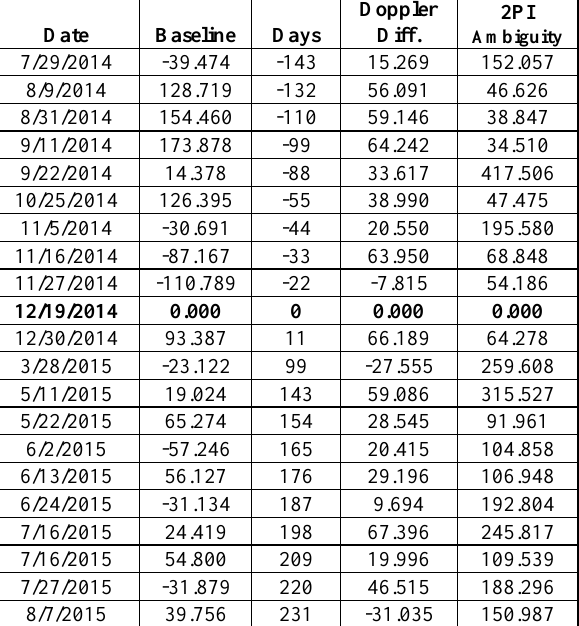
Table 1. ST TerraSAR-x data details: perpendicular and temporal baselines and centroid Doppler difference frequency